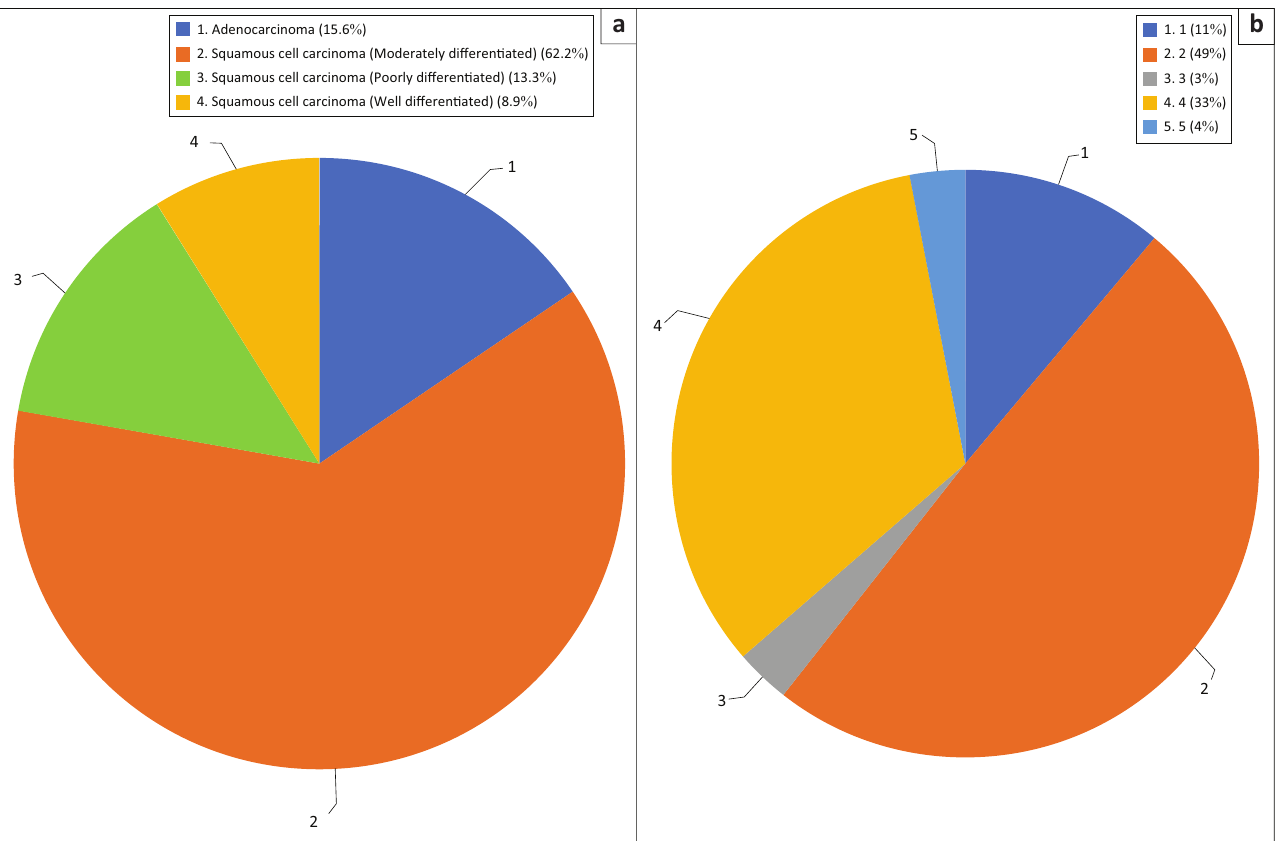
FIG URE 1: (a) Percentage distribution by histological sub-classification type. (b) Percentage distribution by stages of cervical cancer disease.